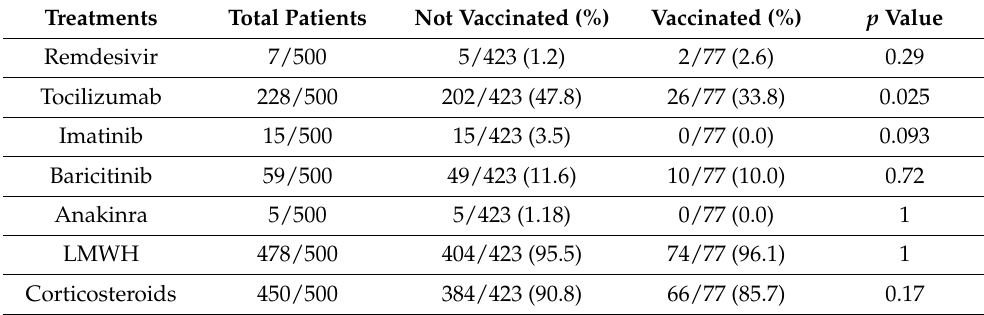
Table 4. Pharmacological treatments received by the both not vaccinated and vaccinated cohorts *. Treatments Total Patients Not Vaccinated (%) Vaccinated (%) Remdesivir